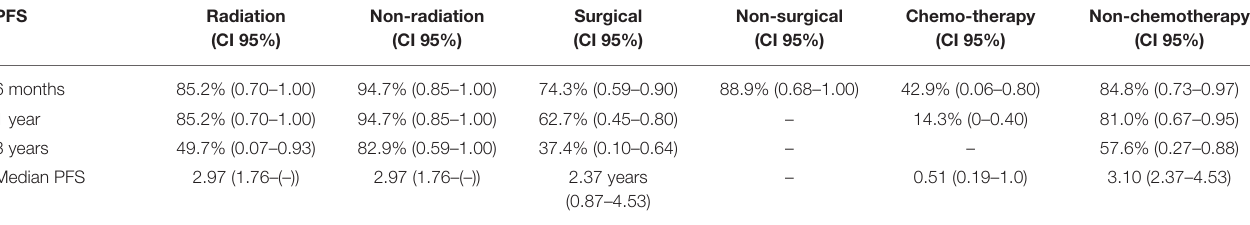
TABLE 3.3 | Median progression free survival and progression free survival based on treatment history at 6 months, 1, and 3 years ( n = 43). PFS